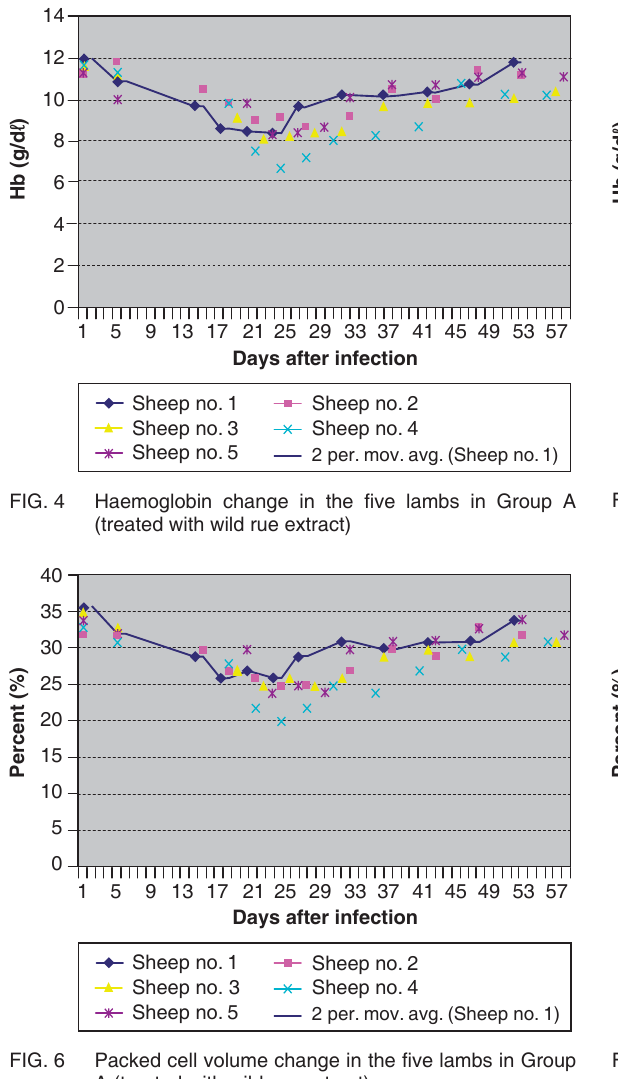
FIG. 5 Haemoglobin change in the five lambs in Group B (un- treated)